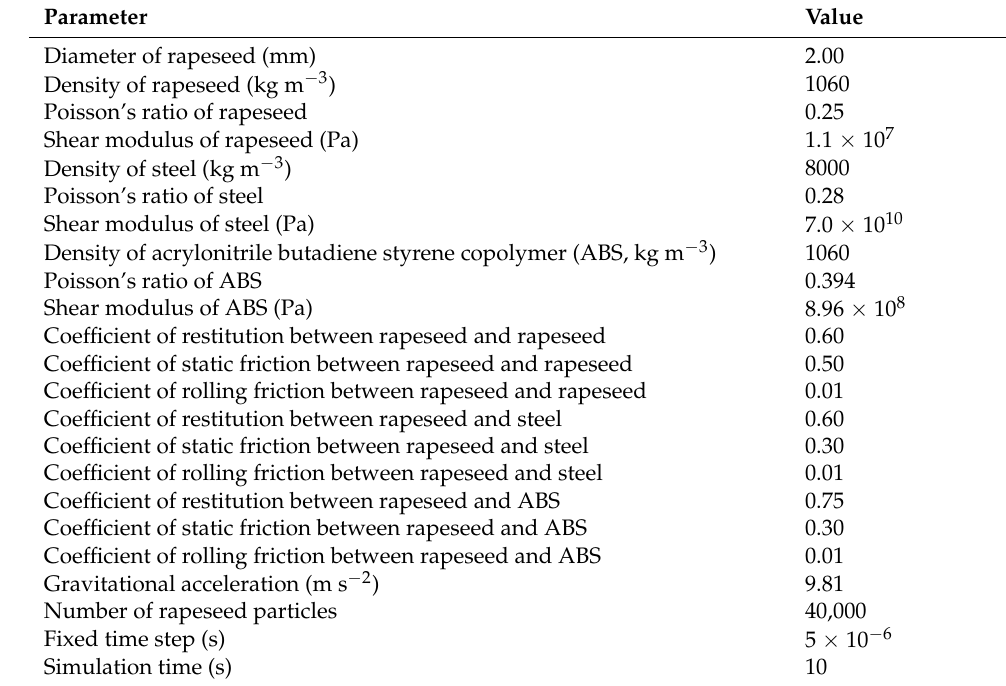
Table 1. Parameters used in the DEM simulations.